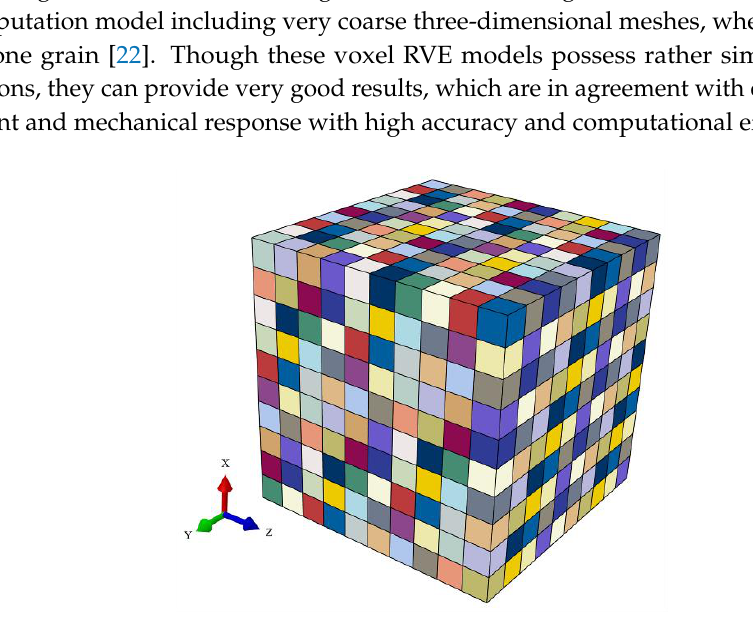
Figure 5. RVE (representative volume element model) of polycrystalline NiTi SMA based on the voxel model.